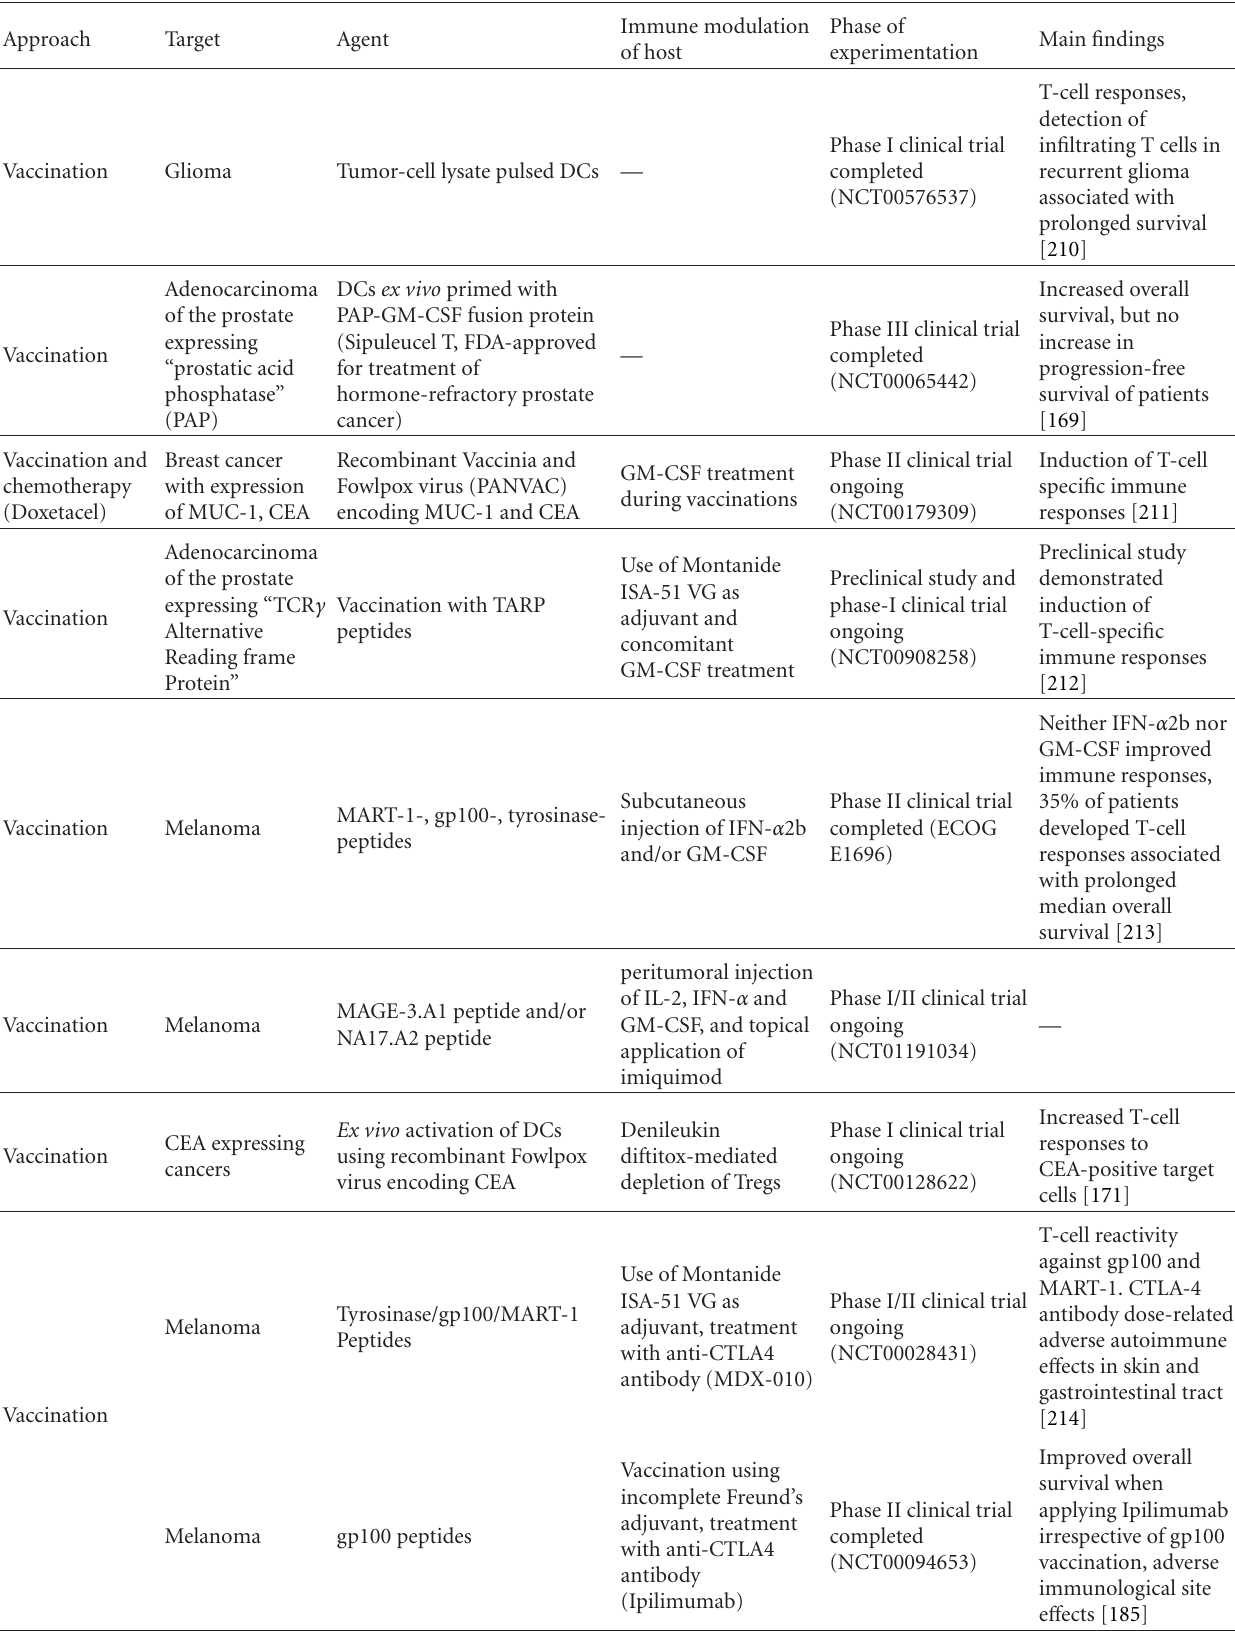
Table 1: Selected approaches to tumor